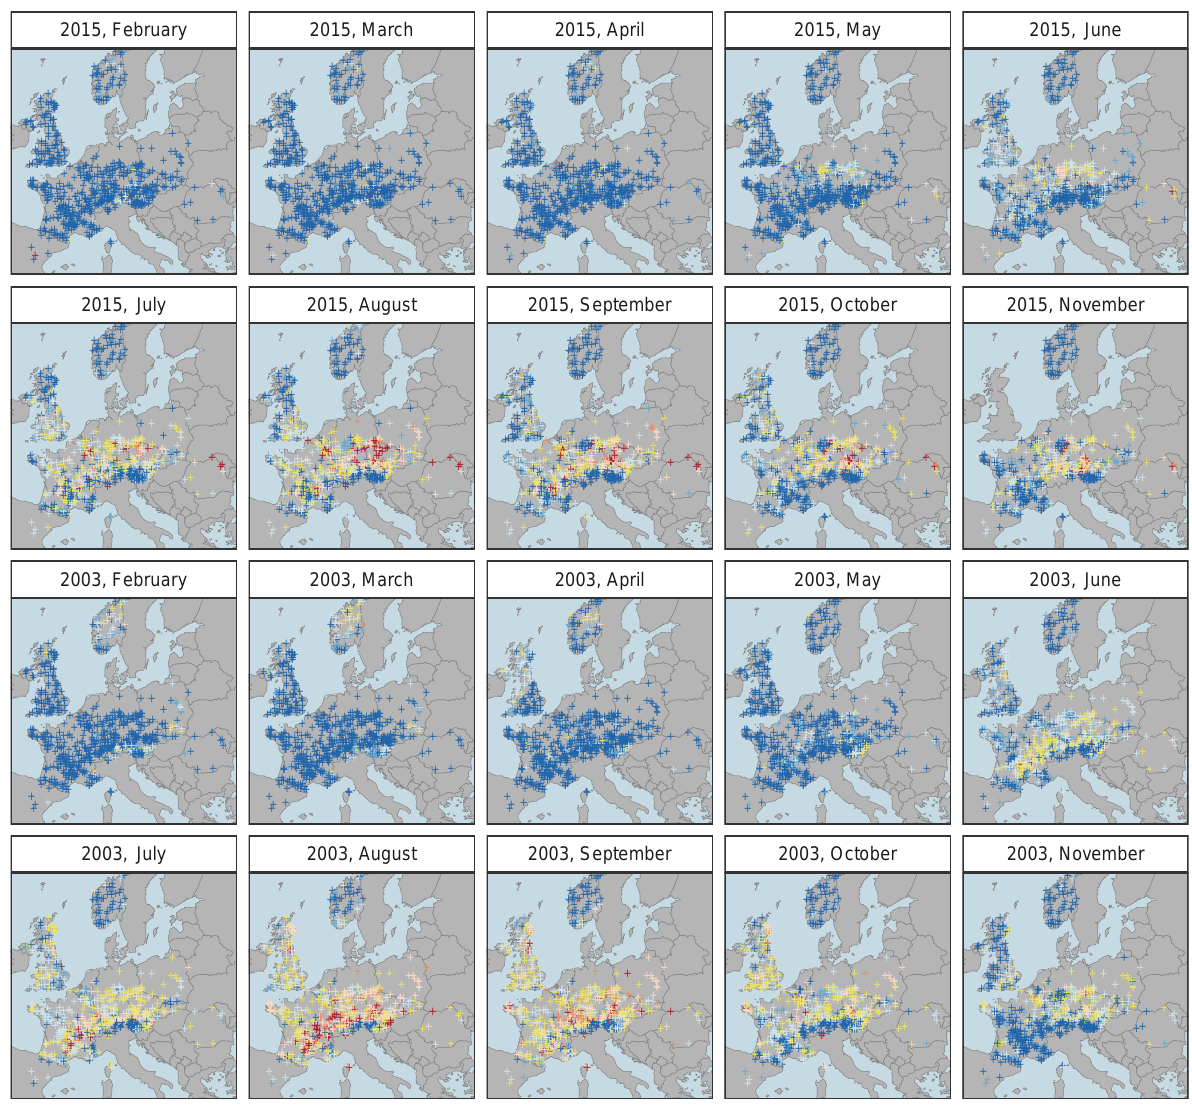
Figure 3. Return period T (in years) of monthly 7-day minimum flows MM7. Color codes are those of Fig.